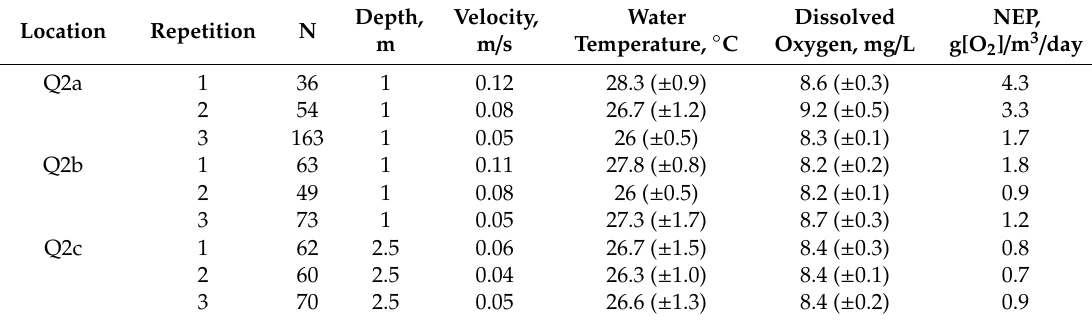
Table 9. River transect examination using average net ecosystem production (NEP) with N number of observations. Location